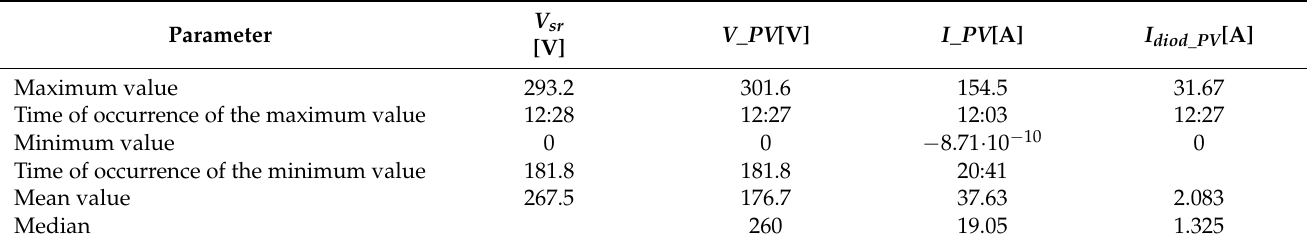
Table 4. Values of voltage and current on PV modules (39.65 kW) and PV diode current on a sample day in July.